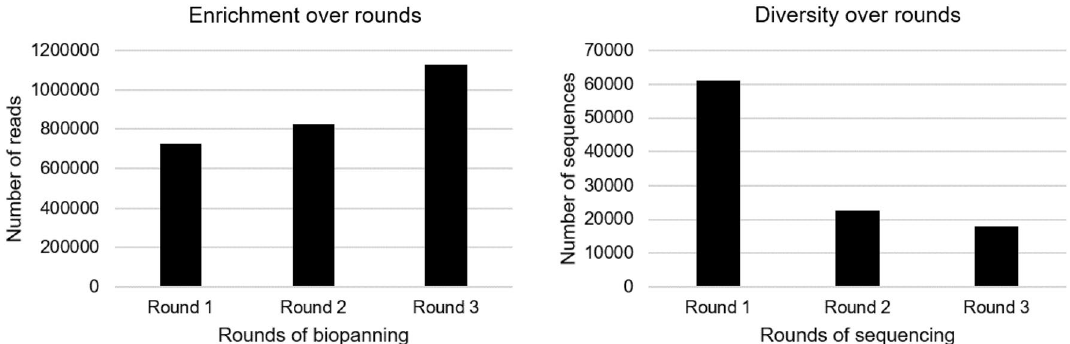
Figure 1. The total number of reads and sequences in each round of biopanning. The Y-axis represents the number of reads (left) or sequences (right). The X-axis represents each round of